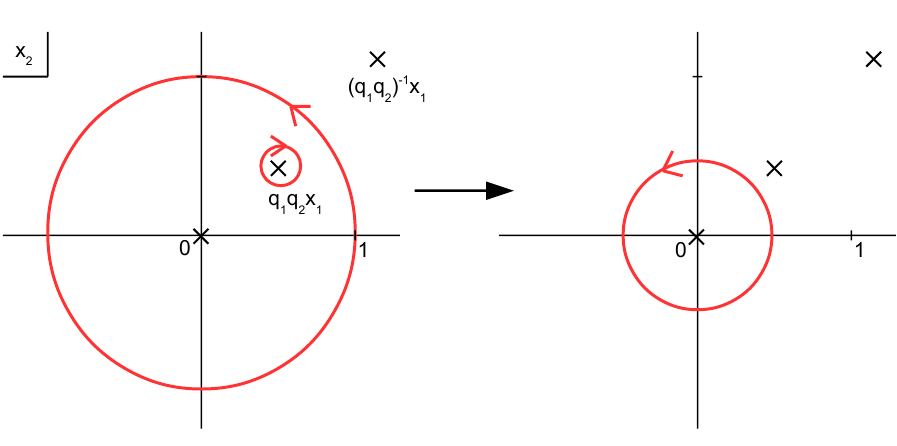
Figure 7 . Contour C (red) for the x 2 integration, assuming x 1 is integrated (after x 2 ) on the unit circle. On the left: we exclude the residue at x 2 = q 1 q 2 x 1 (keeping only the residue at zero). This can be achieved by choosing the integration circle on the